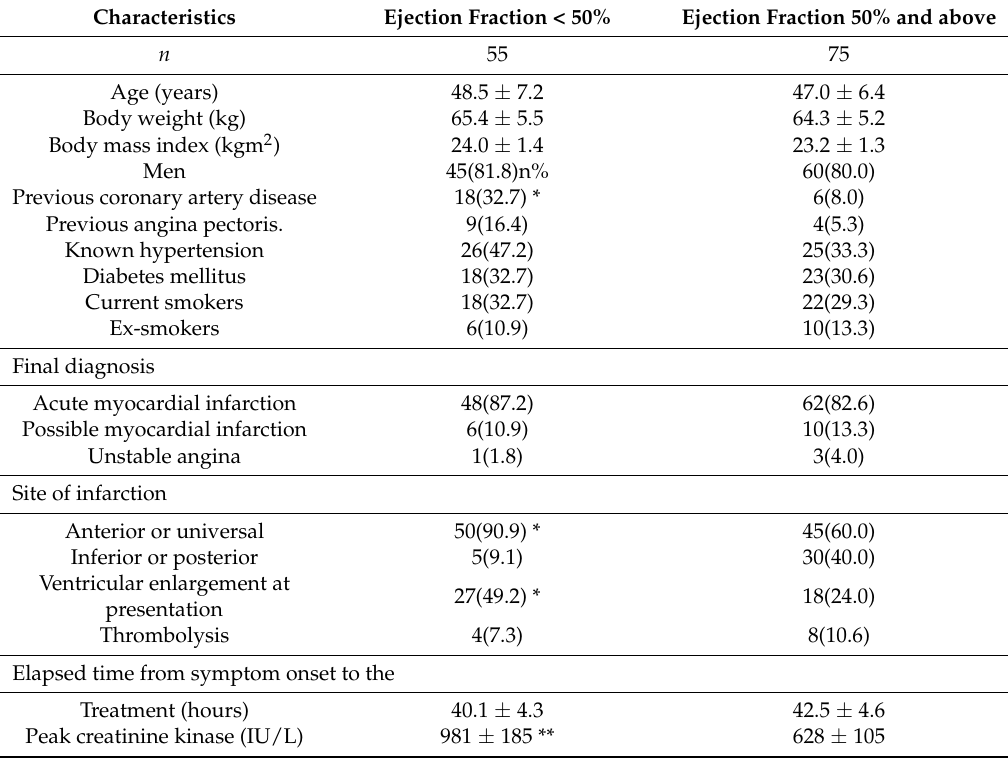
Table 1. Baseline characteristics of patients with left ventricular ejection fraction <50% compared to subjects with ejection fraction 50% and